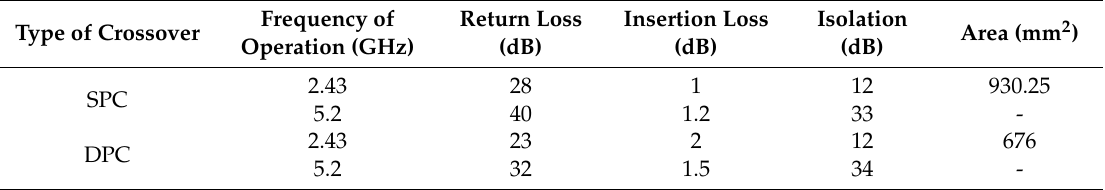
Table 1. Comparison of Dual band Crossover characteristics — Experimental data ( ε r = 4.4, h = 1.6 mm,